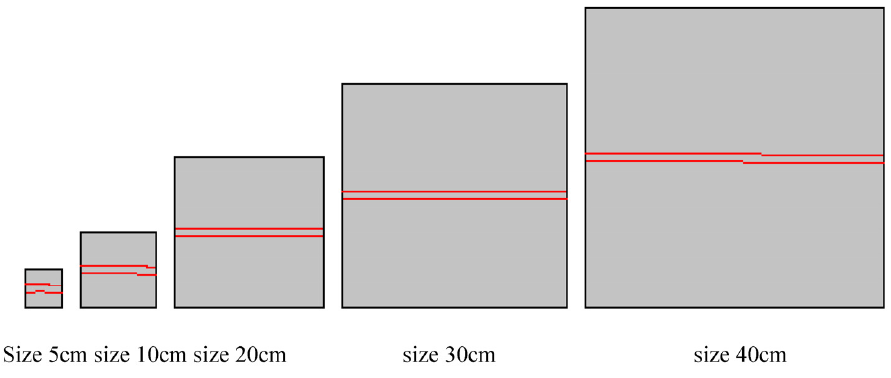
Figure 2. Rock model of different sizes when the NPJ is 2.